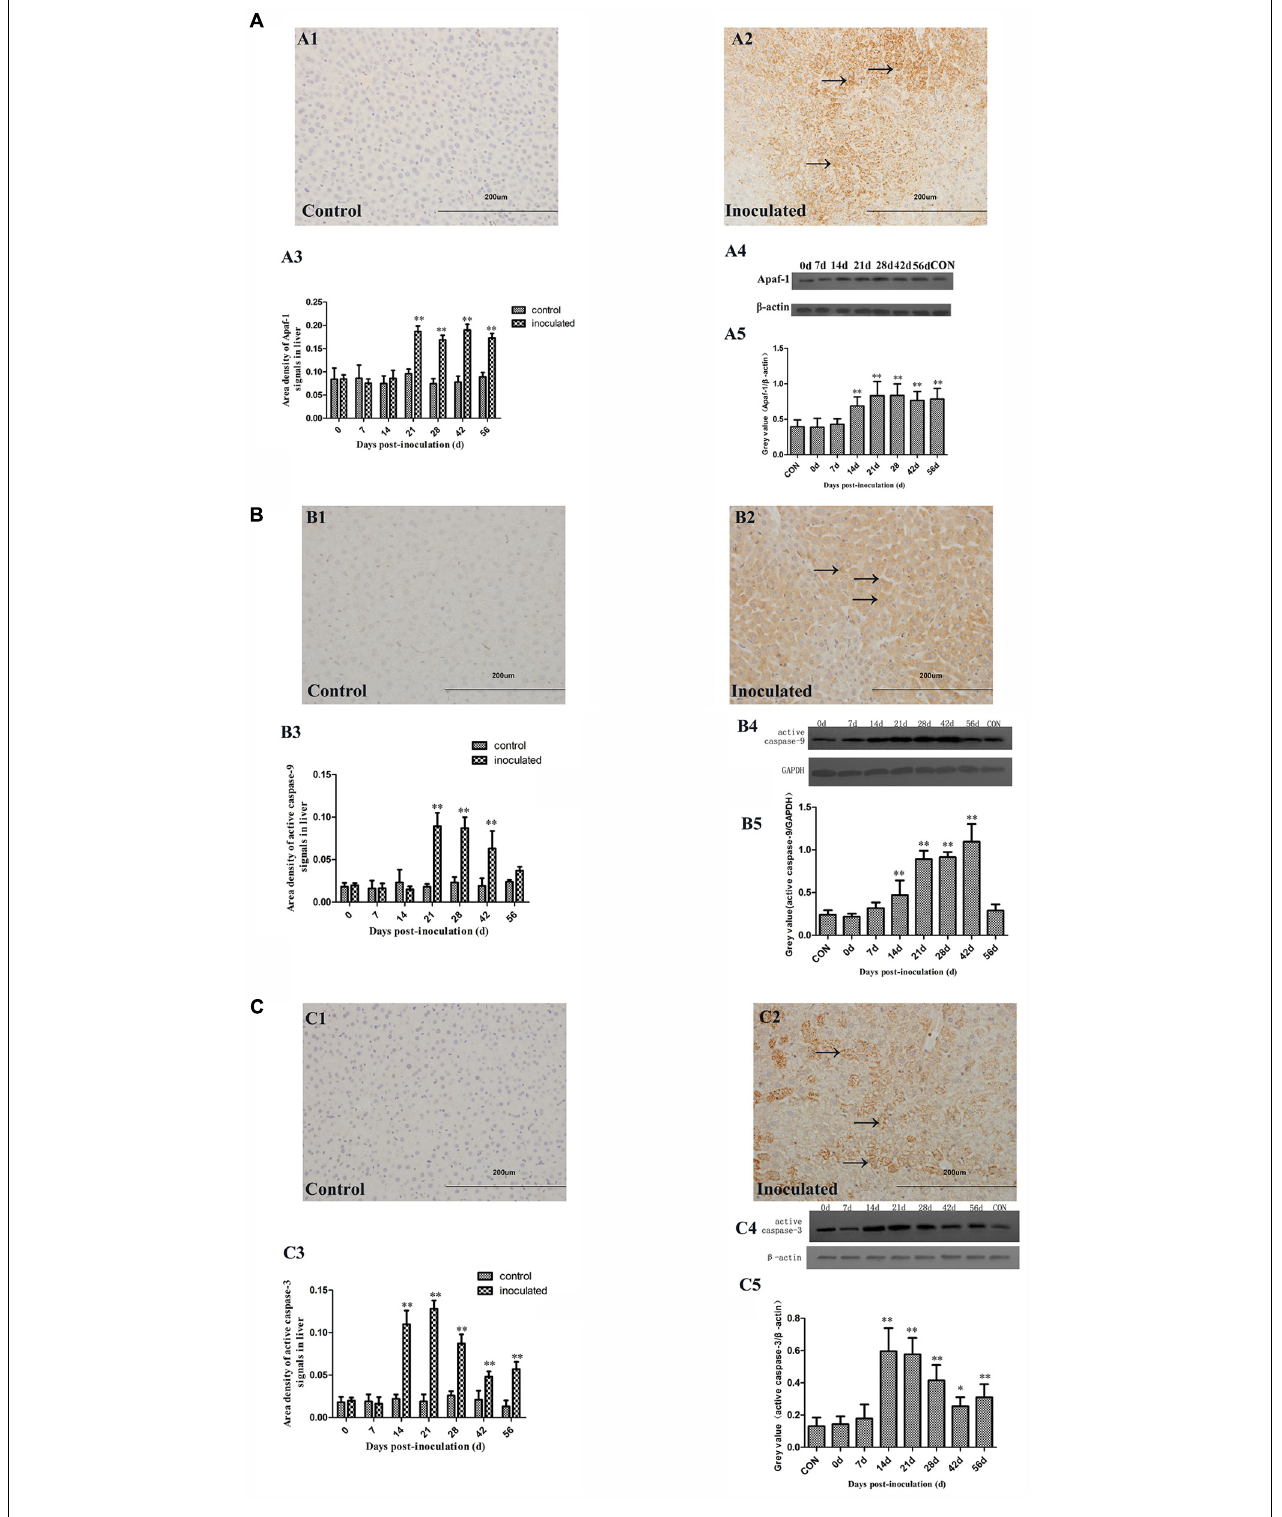
FIGURE 6 | Immunohistochemical and western-blot analysis of Apaf-1, active caspase-9, and active caspase-3 proteins. (A1) IHC analysis of livers in control group, (A2) IHC analysis of livers in inoculated group. The primary antibody was Apaf-1 antibody, and the positive signals were observed in the cytoplasm of hepatocyte ( → ); (A3) A semi-quantitative analysis of the ratio of Apaf-1 positive staining to the total field; (A4) Western-blot analysis of Apaf-1 protein in hepatocyte of control group